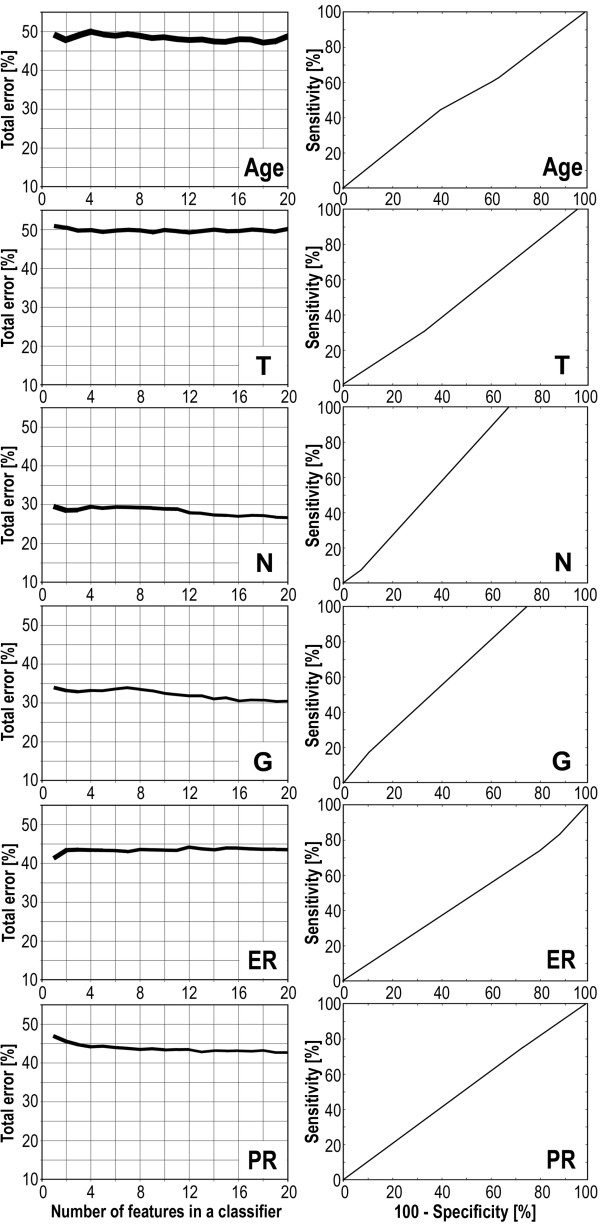
Estimation of differences of serum proteome patterns between sub-groups of breast cancers patients. Patients were differentiated by age, primary tumor size (T), lymph nodal status (N), histopathological grade (G), and estrogen (ER) and progesterone (PR) receptor expression. A – The total error rates of classification plotted against the number of features in the classifiers as in Fig. 1A; the actual line width corresponded to 95% confidence intervals. B – ROC curves computed for classifiers built of 15 spectral components for each comparison (computation was done as described in Fig. 1B).